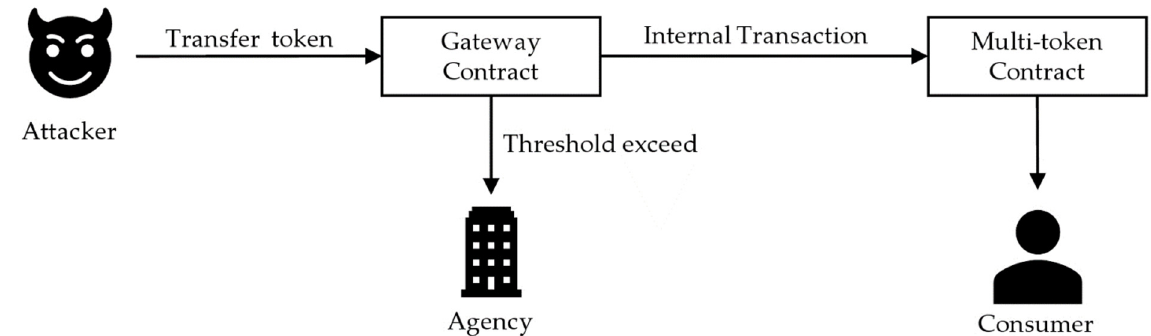
Figure 12. Threshold logic included in gateway contracts.